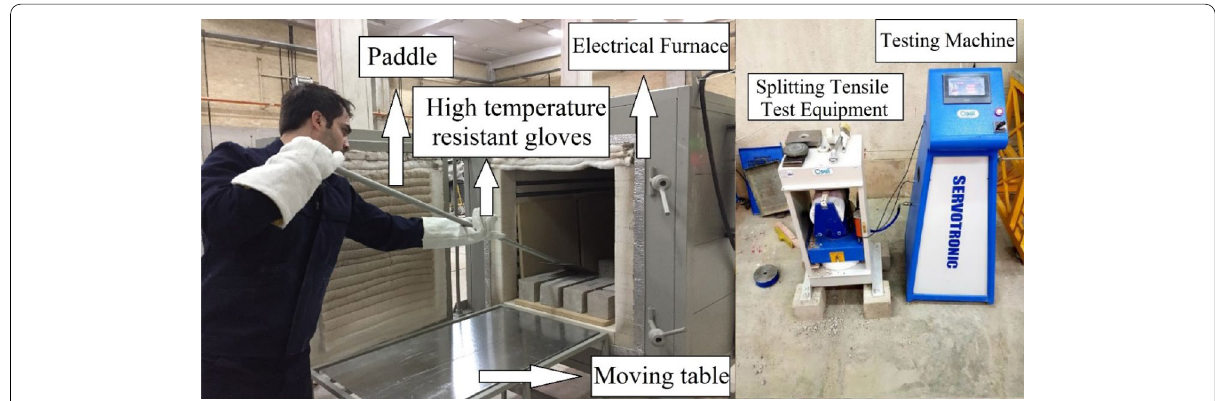
Fig. 2 Detail of the apparatus and test